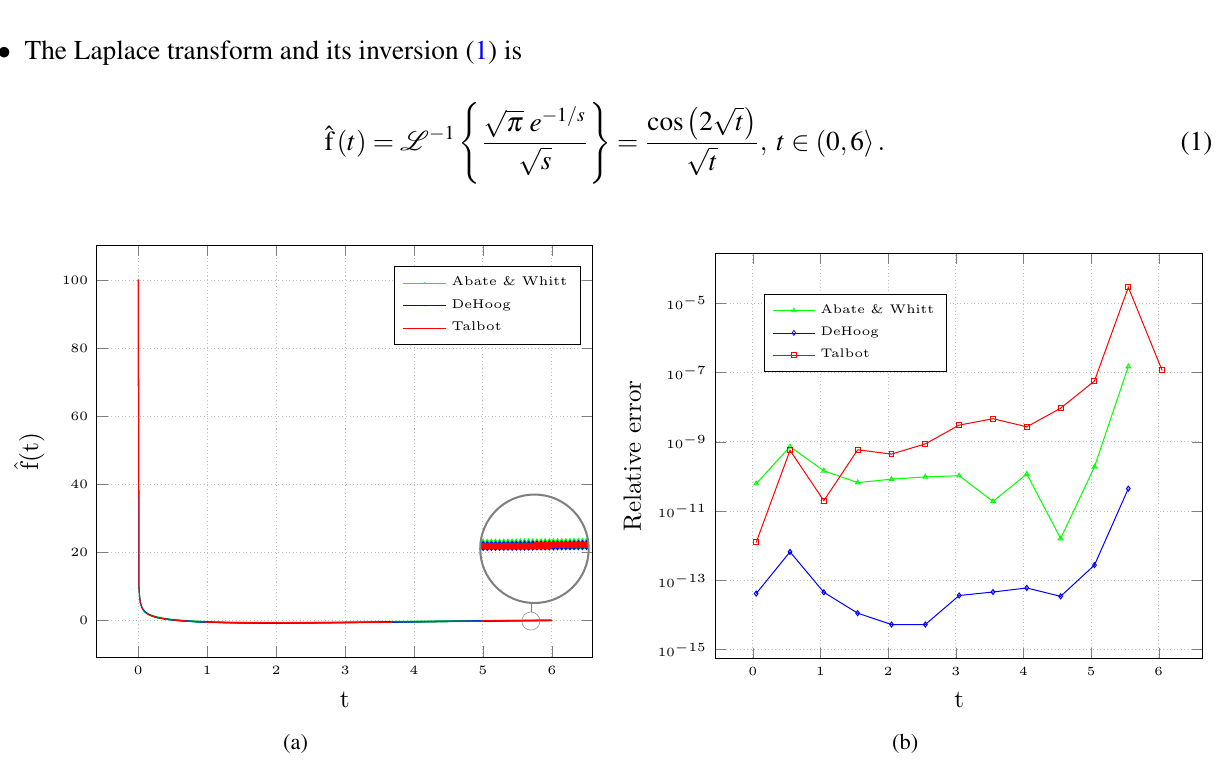
Fig. 1 Plots of numerical inversions ˆf ( t ) of the Laplace transform (1) (a) and their relative errors (b) for applied methods in interval ( 0 , 10 (cid:105)